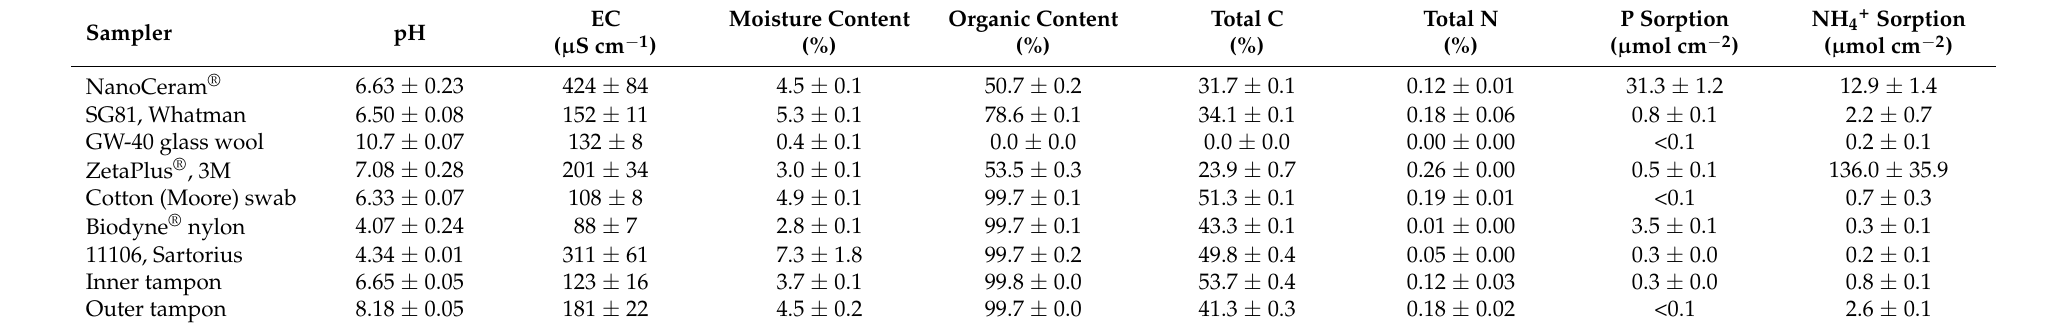
Table 3. Basic physical and chemical characteristics of the passive sampler materials used in the trials. Values represent means ± SEM ( n = 3).